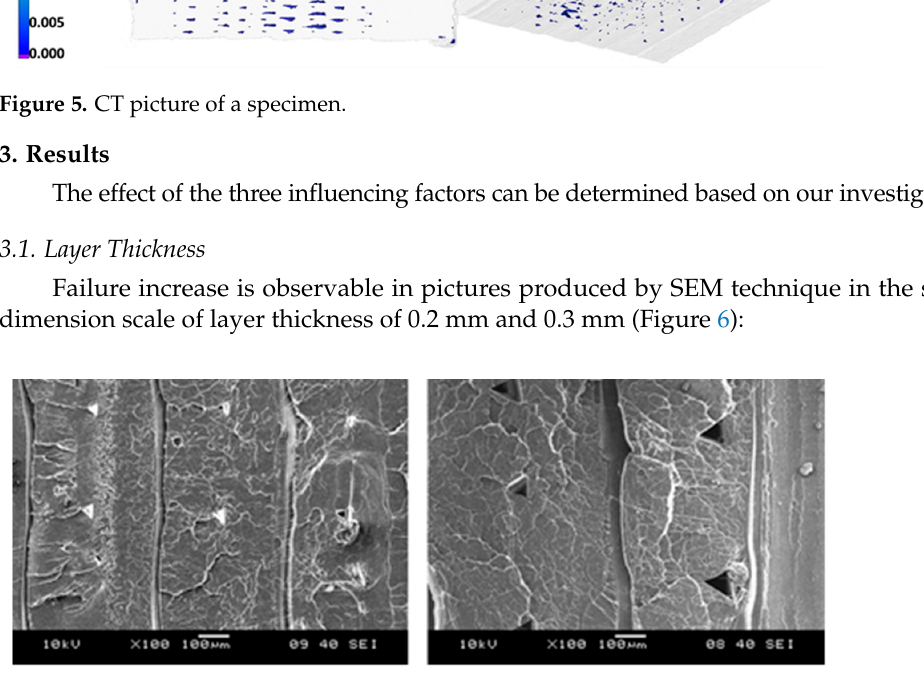
Figure 6. Scanning Electron Microscope (SEM) pictures of layer thickness of 0.2 and 0.3 mm, in the same dimension scale.